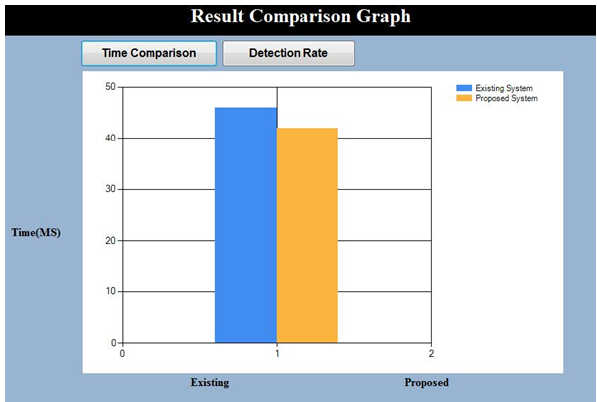
Fig. 3. Analysis and comparison of Time required for detection of mask between existing algorithms and proposed